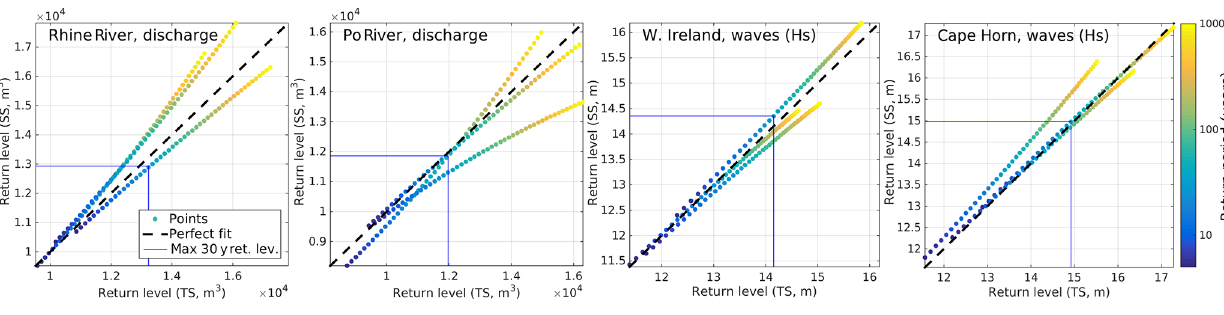
Figure 9. Return levels modeled by the TS methodology ( x axis) vs. those modeled by the SS methodology ( y axis) for the discharge of the Rhine and Po rivers and the significant wave height in west Ireland and Cape Horn. The three series of dots represent the three time slices. Dots’ color represents the return period. The blue lines represent the maximum 30-year return